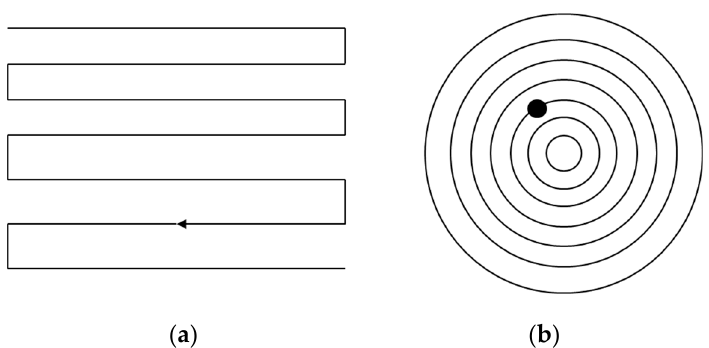
Figure 1. Conventional polishing paths based on CNC processing: ( a ) raster polishing path and ( b ) concentric circle path.